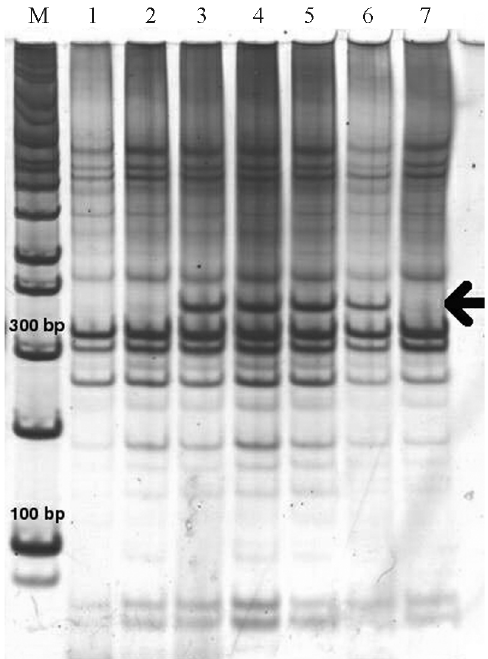
Figure 1 - Polymorphic patterns obtained from cultivars of the sweet or- ange (L. Osbeck) using the CCSM13 locus. M = 1 kb ladder; 1 = Pêra IAC; 2 = Lanceta; 3 = Natal; 4 = Westin; 5 = Hamlin; 6 = Valência; 7 = Pêra GS 2000. Conditions: 10% (w/v) polyacrylamide gels (29:1 acrylamide/bisacrylamide), 5X TBE